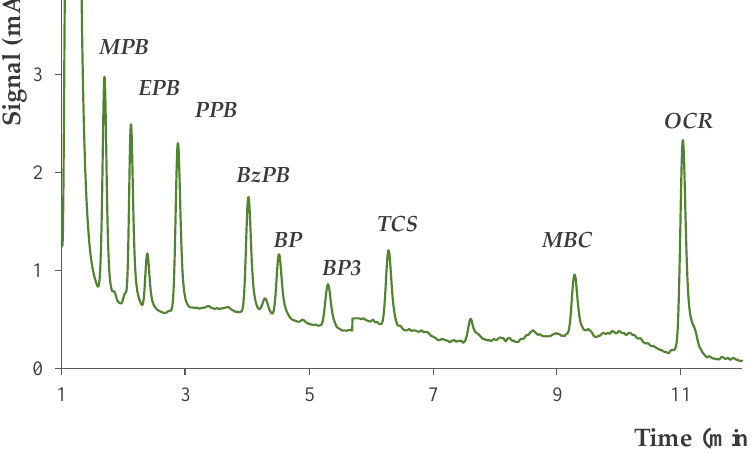
Figure 6. Representative chromatogram obtained by subjecting a wastewater sample (spiked at 45 µg·L − 1 ) to the overall optimized D-µSPE-UHPLC-UV method.